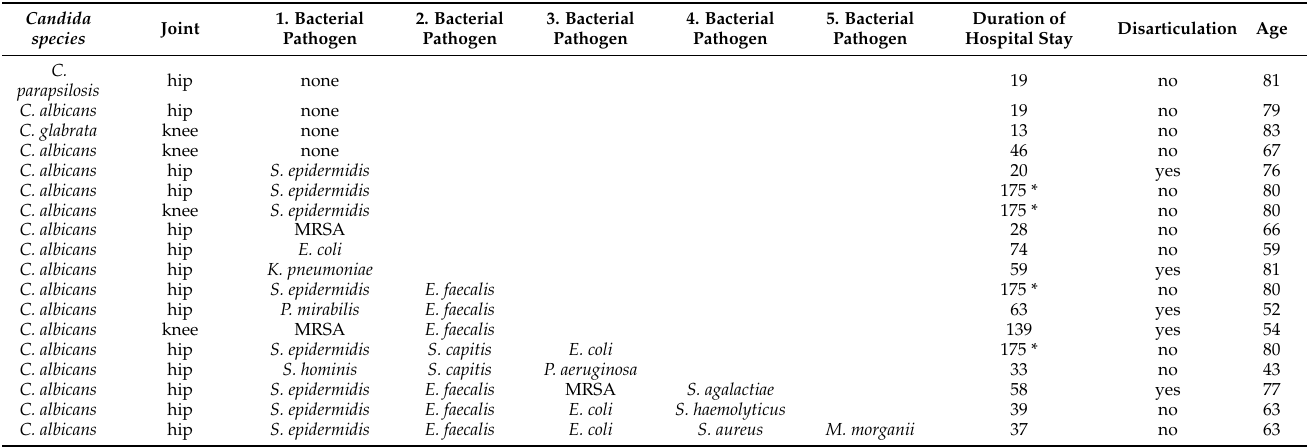
Duration of stay in days; age in years; MRSA = methicillin-resistant S. aureus; * = different surgical procedures with detection of C. albicans in the same patient as part of the same hospital stay with a total length of 175 days. For the statistical evaluation the duration of 175 days was only included once in the calculation of mean and median of the length of the hospital